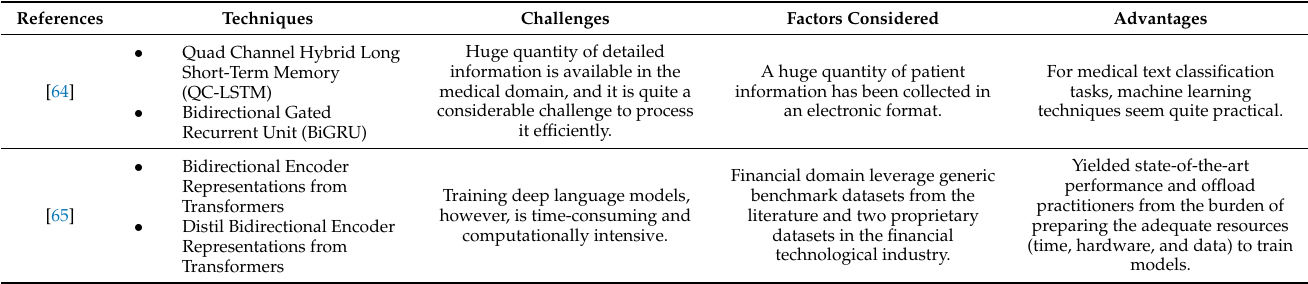
Table 1. Summary of the related work regarding text